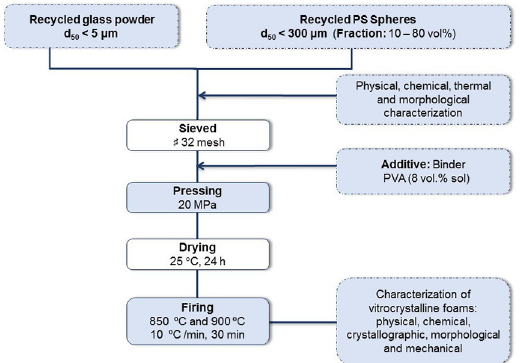
Figure 1. Flowchart for production of vitrocrystalline foams by sacrificial template